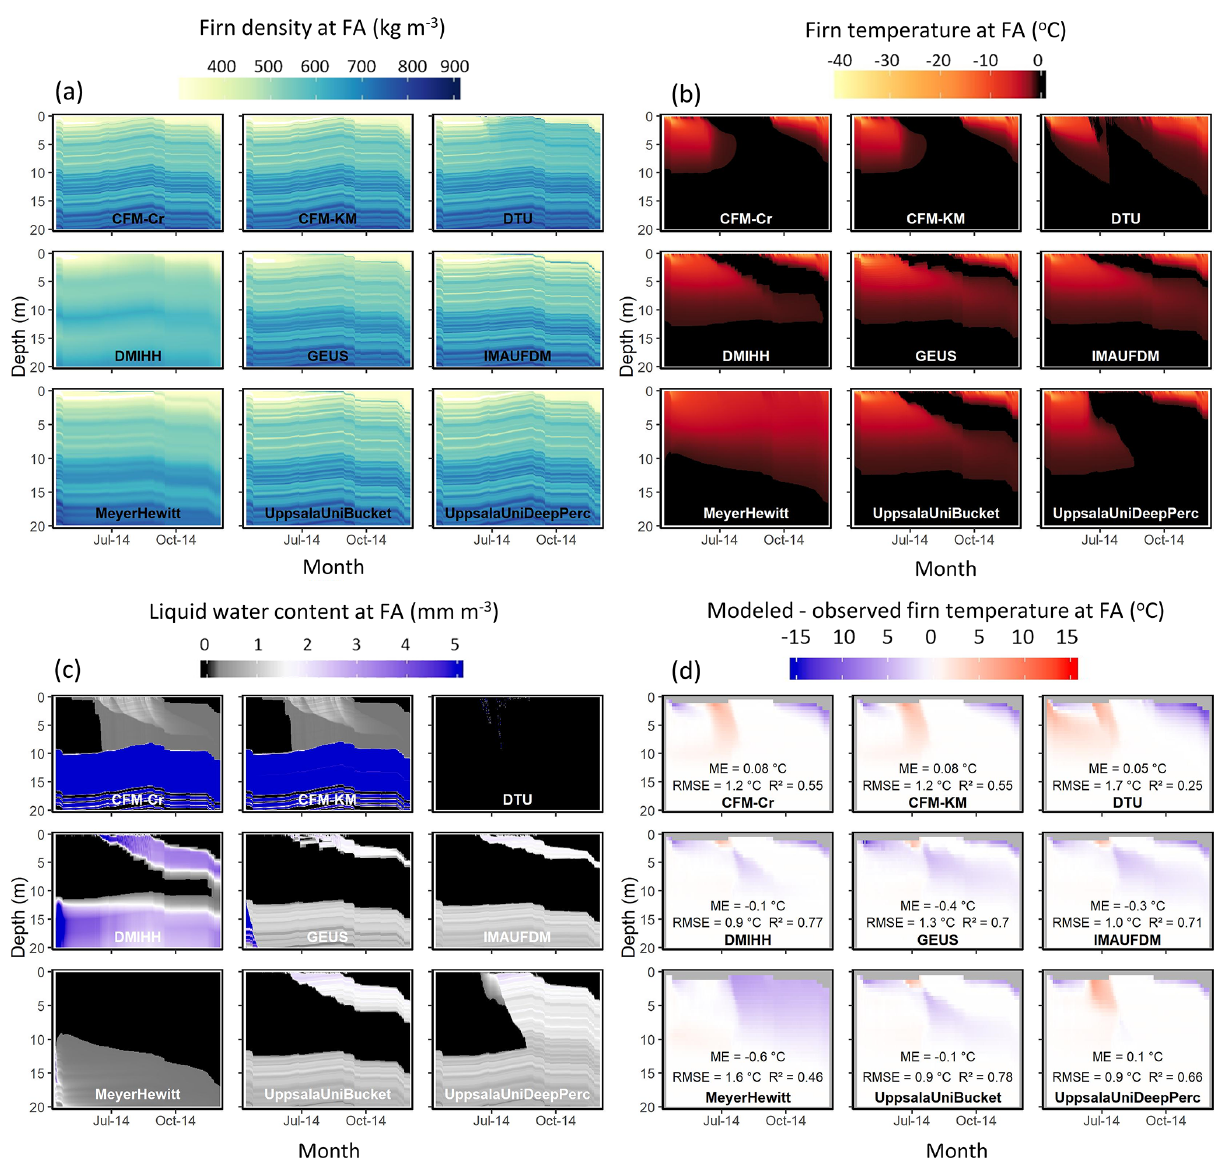
Figure 10. Simulated firn density (a) , temperature (b) , water content (c) , and deviation between simulated and observed firn temperature (d) at